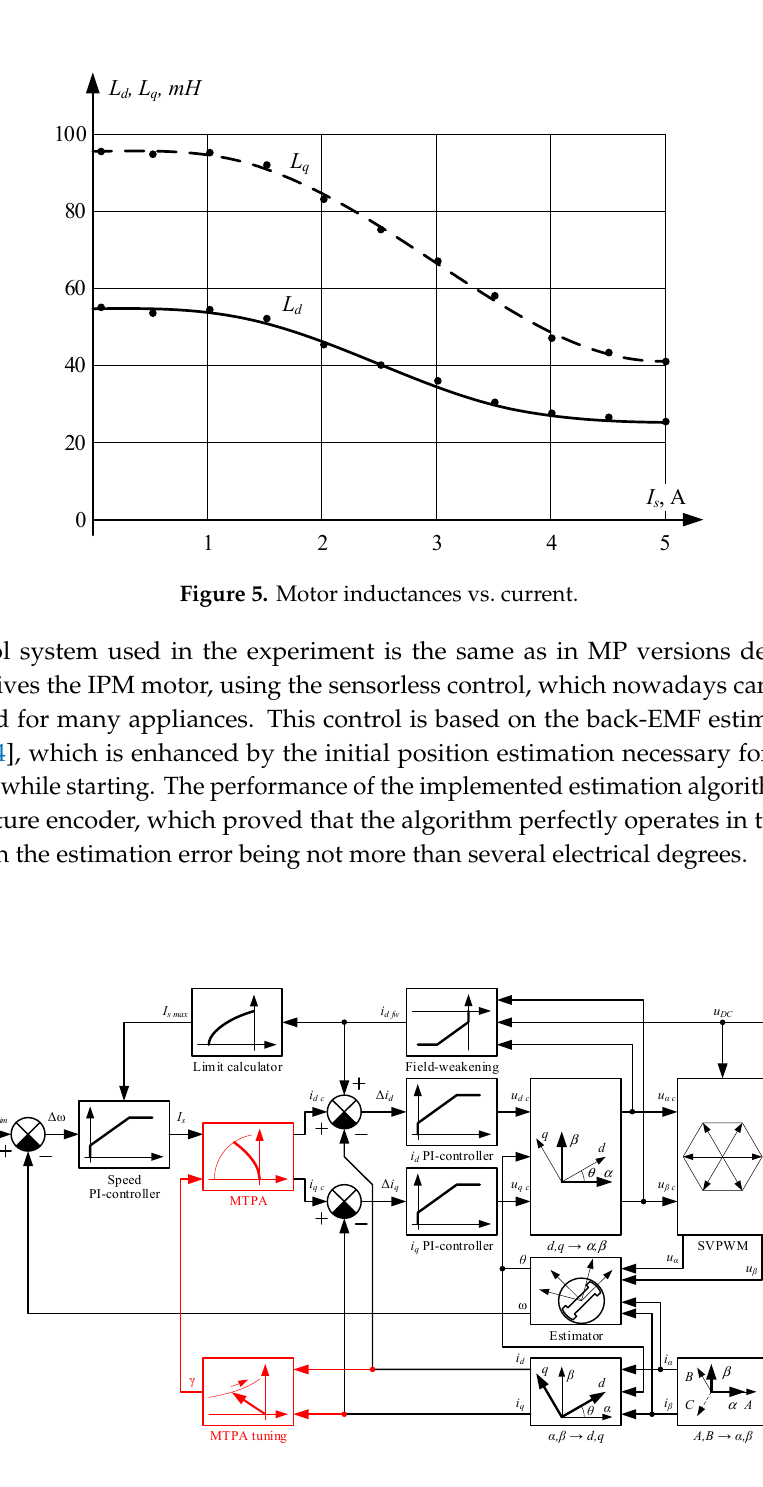
Table 2. Motor Rated Parameters.